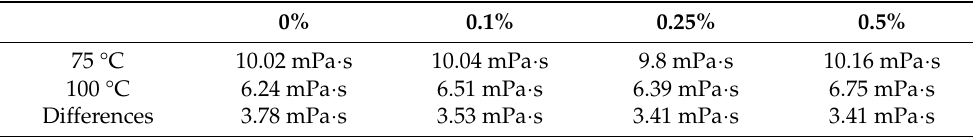
Figure 14. Dynamic viscosities of the oil samples containing different IF–WS 2 additives before and after the wear test at 75 ◦ C and 100 ◦ C. Table 3. Dynamic Viscosity and Difference of IF–WS 2 /PAO6 with different content at different